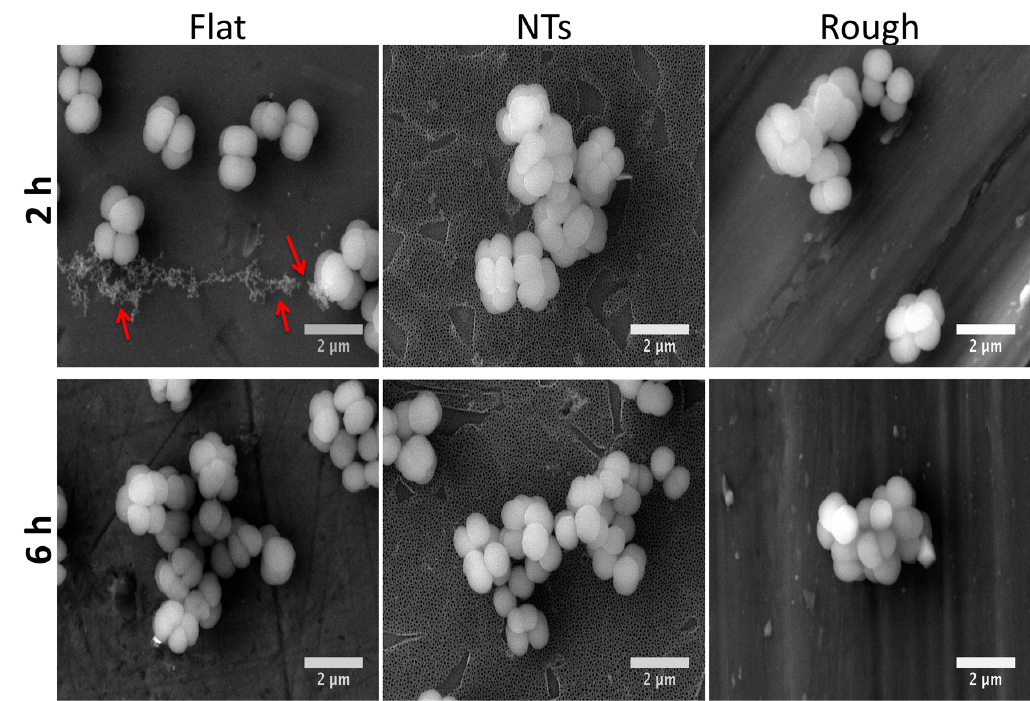
Figure 4. S. epidermidis organization onto the materials surfaces at 2 and 6 h of incubation. Note that the flat surface mainly stimulates the synthesis of exopolisacharides at 2 h of growth (red arrows).